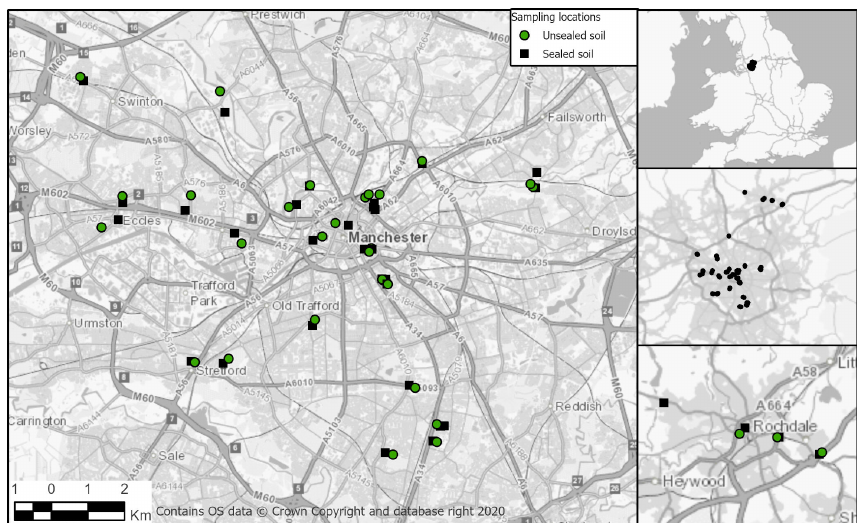
Figure 1. Map showing sampling locations across the Greater Manchester